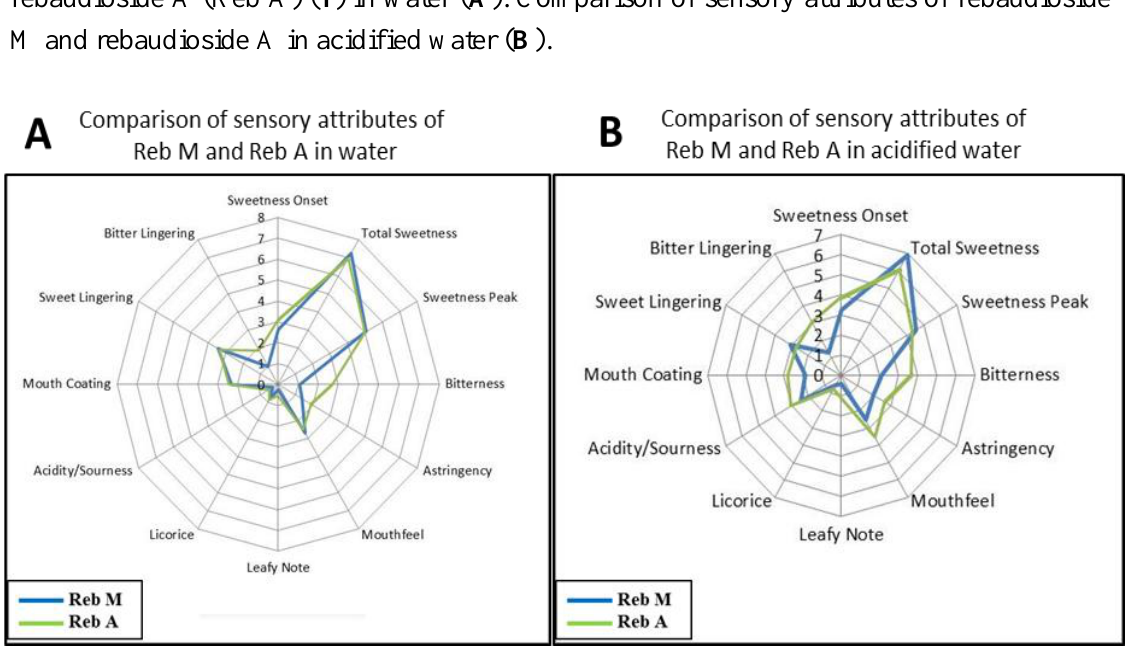
sucrose at 10% in water at room temperature were compared over a period of 3 min (samples were swallowed at 5 s). The AT maximum was the shortest for sucrose, slightly longer for aspartame and longest for rebaudioside M. The ET was longest for rebaudioside M, followed by aspartame and then